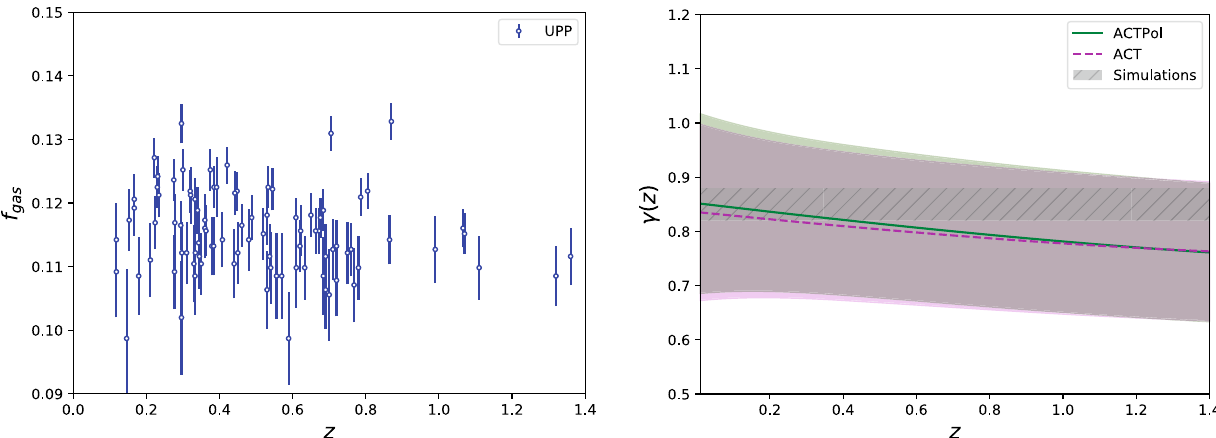
Fig. 5 Gas mass fraction derived from ACT compilation [11] (left panel) and the corresponding reconstruction of the gas depletion factor γ( z